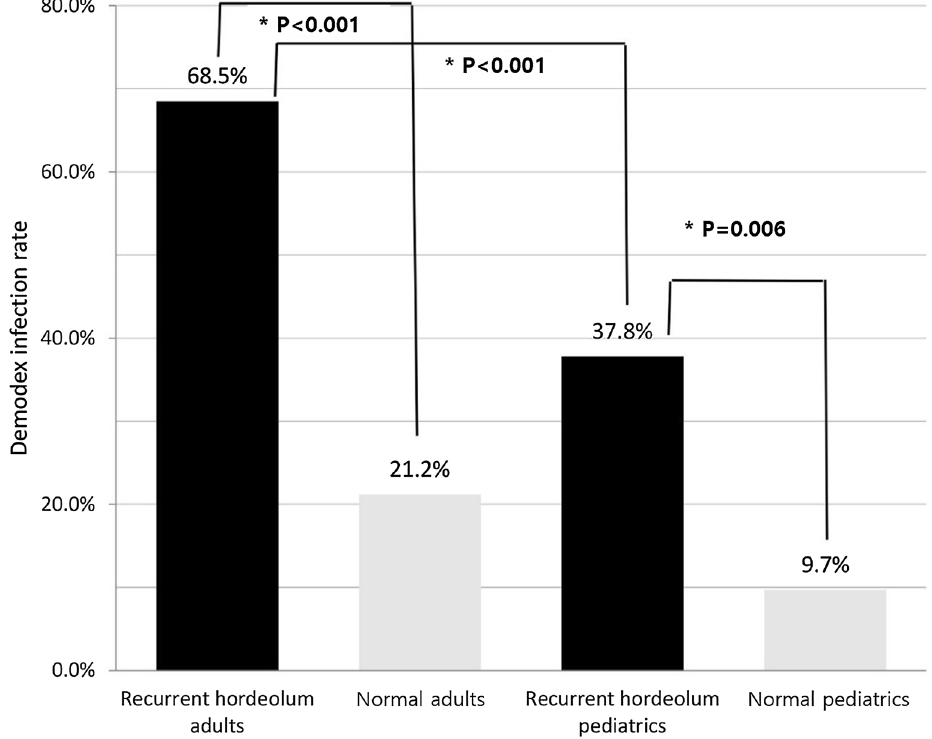
Figure 3. Incidence of Demodex infestation in adult and pediatric patients in the recurrent hordeolum and control groups. This graph demonstrates a significantly higher rate of Demodex infection among adult patients than among pediatric patients in the recurrent hordeolum